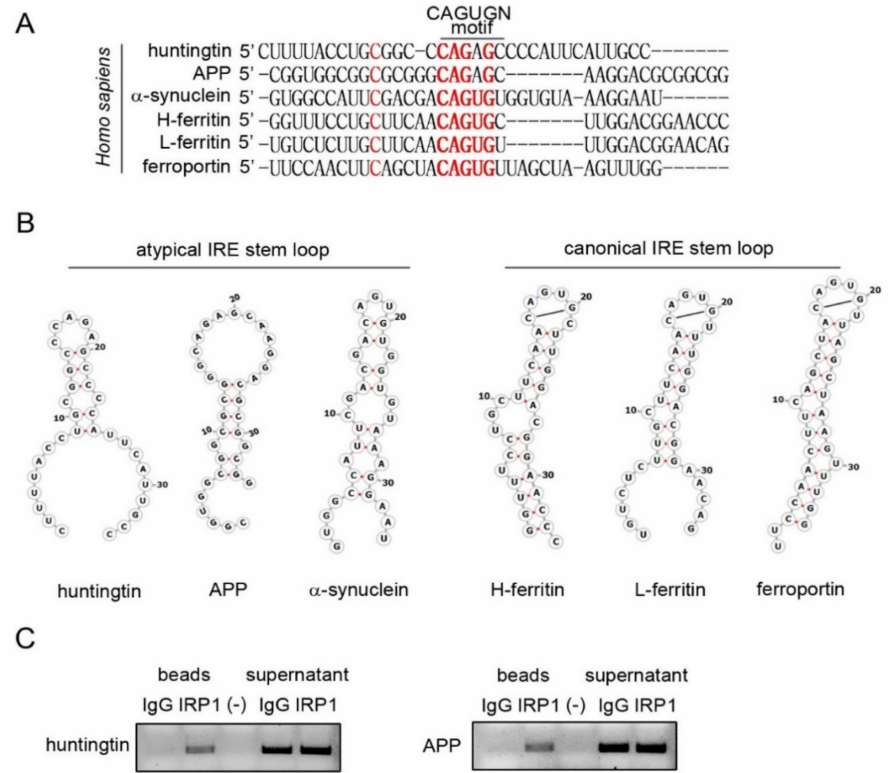
Figure 4. The 5 (cid:48) -UTR of HTT mRNA contains an atypical IRE Stem loop. ( A ) Alignment of the predicted IRE in the 5 (cid:48) -UTR of HTT mRNA against to the IREs of APP, α SYN, L-ferritin, H-ferritin and ferroportin mRNAs. Highlight in red are the conserved bases in the CAGUGN motif and an unpaired “bulge” cytosine. ( B ) The atypical 5 (cid:48) -UTR IRE stem loops of APP , SNCA ( α -synuclein) and HTT mRNAs differ from canonical IREs found in L-and H-ferritin and ferroportin mRNAs. Both types of IREs, the canonical and atypical IREs, bind to IRP1. However, Posiphen only inhibits the translation of neurotoxic proteins whose mRNAs have an atypical IRE in the 5 (cid:48) -UTR. ( C ) Representative IP-RT- PCR experiment showing that HTT mRNA binds IRP1. SH-SY5Y cell lysates were incubated with either IPR1 specific antibody or control IgG and Dynabeads Protein A slurry. Following IP, RT-PCR was performed from RNAs extracted from both beads and supernatant fractions where specific HTT and APP primers were used to detect the presence/absence of each transcript ( n =